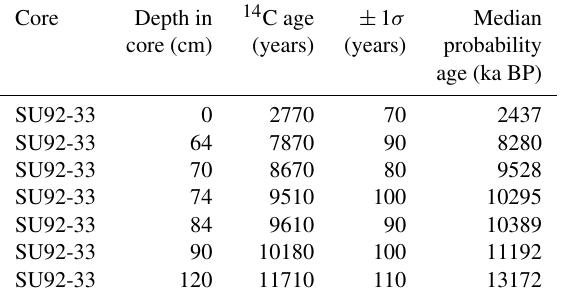
Table 3. AMS 14 C ages of samples of the planktonic foraminifer G. bulloides from “off-mound” sediment core SU92-33. The AMS 14 C ages were corrected for 13 C and a mean reservoir age of 400 years, and were converted into calendar years using the INTCAL13 cali- bration data set (Reimer et al., 2013) and the CALIB 7.0 program (Struiver et al.,